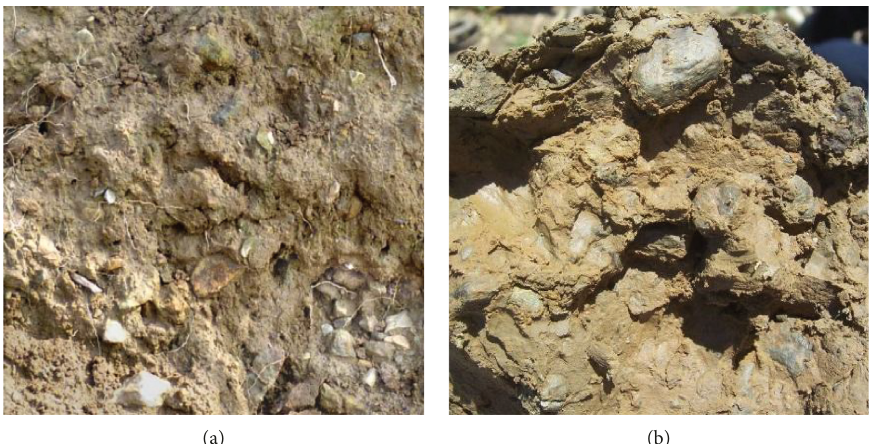
Figure 2: Structure of the geomaterial in the Baishuihe landslide. (a) Colluvial-deluvial deposit soil-rock mixture of the slide mass. (b) Gravel soil of the sliding zone.